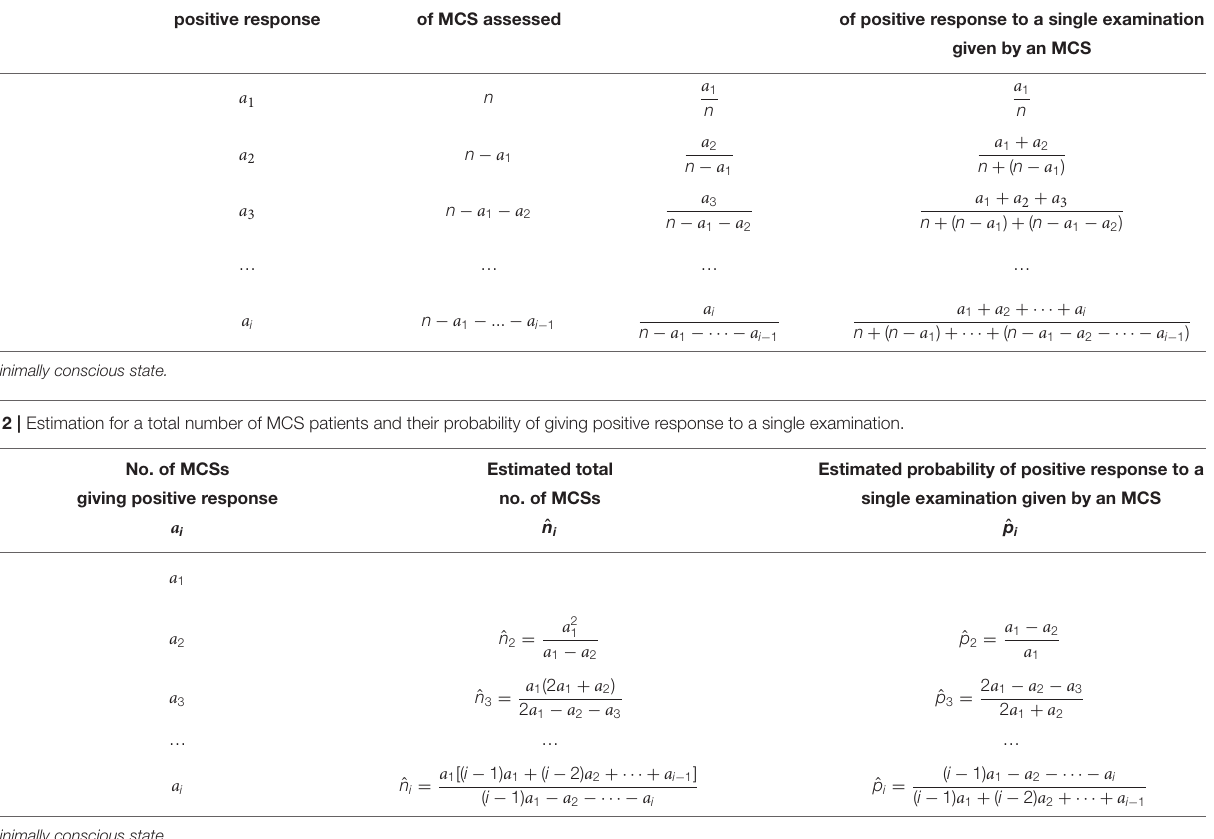
given by an MCS